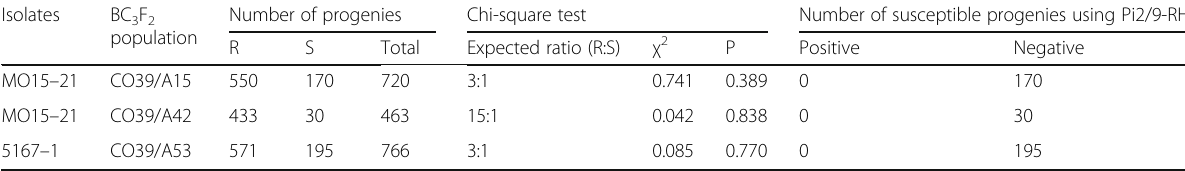
Table 5 Linkage analysis between blast resistance and the Pi2/9 haplotypes in introgression lines Number of Isolates BC 3 F 2 population